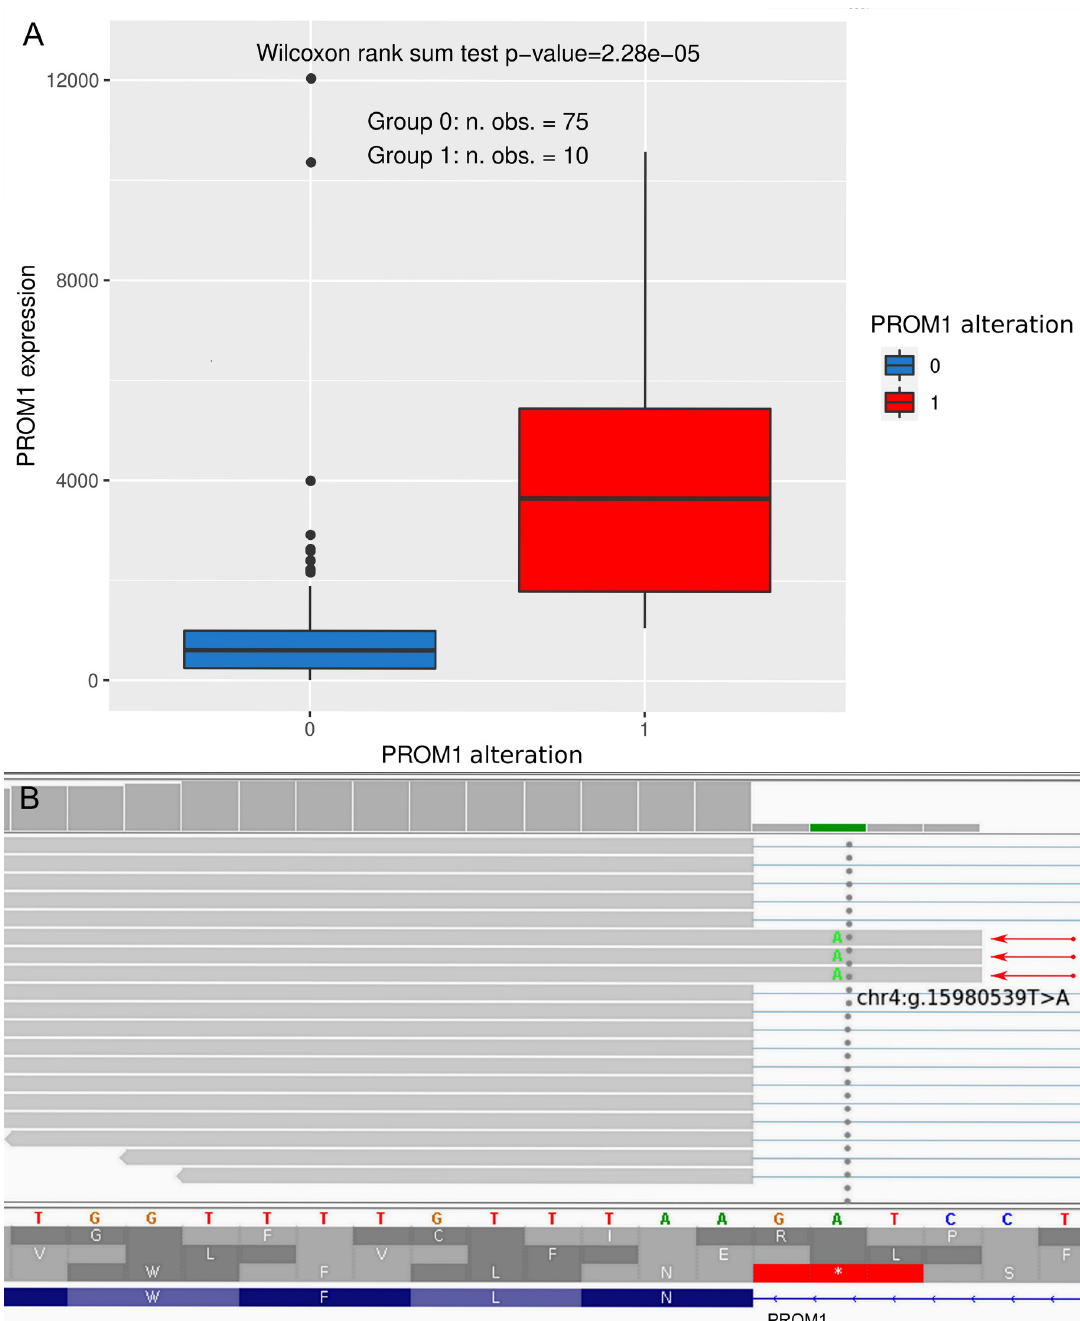
Fig 5. PROM1 gene analysis. The PROM1 gene alterations (denoted by “1”) and overexpression were found to be positively correlated (A). In Fig B, the chr4:g.15980539T > A (ENST00000447510.7:c.2374-2A > T) genetic alteration is shown, being a novel, splice acceptor variant, leading to the formation of an abnormal mRNA transcript (marked with red arrows). Since the PROM1 gene is encoded by the minus DNA strand, the reference sequence of this strand is displayed. treated HGSOC patients. This step involved the Real-Time qPCR analysis and detailed statisti- cal inference with multivariate Cox and logistic regression models in subgroups with different TP53 mutation statuses. The analysis revealed 49 genes the altered expression of which affected